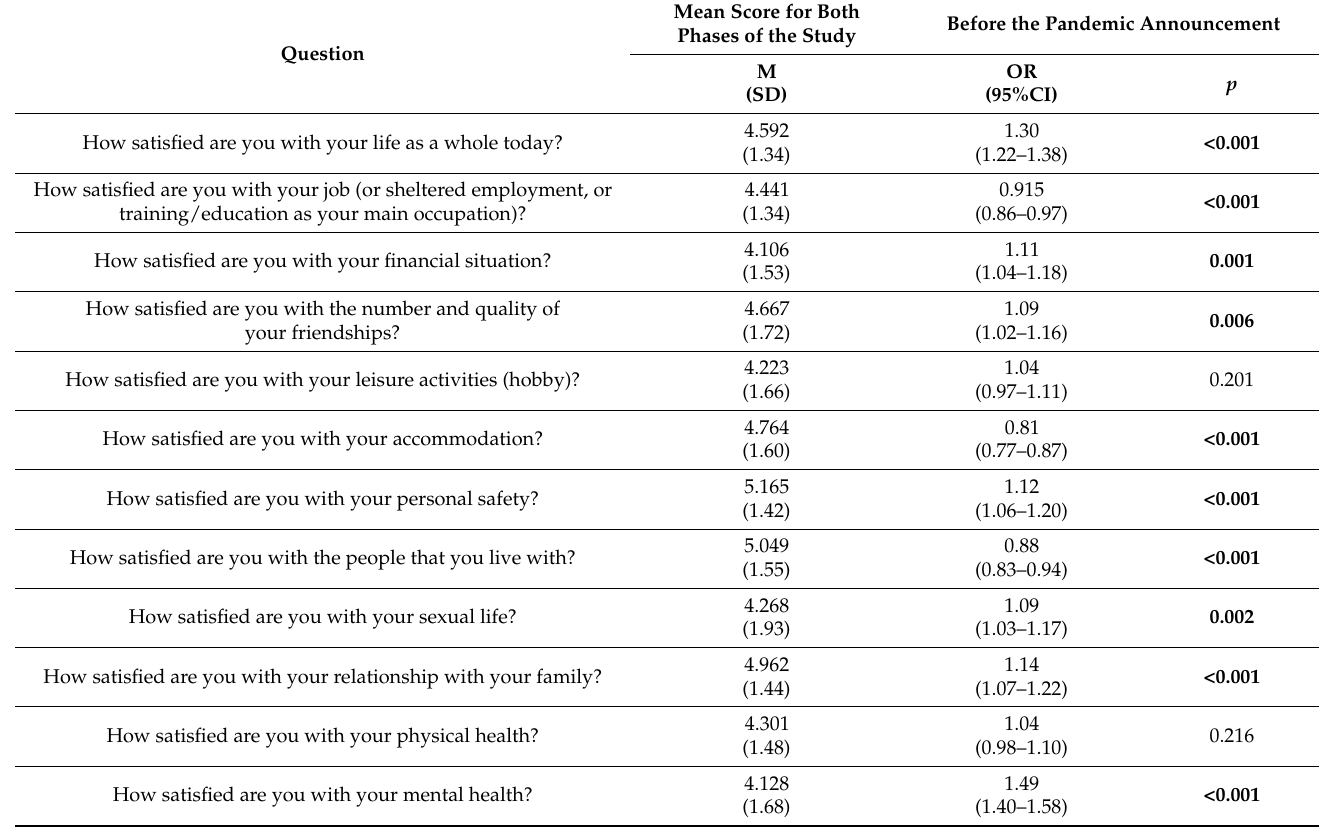
student population. There was a significant influence of gender on the type of stimulants. Women used sedatives/sleeping pills more often, whereas men consumed alcohol, and used cannabinoids and psychostimulants more often. With alcohol consumption, we ob- served a distinct pattern that a higher year of study was associated with increased alcohol use. It was also shown that after the COVID-19 pandemic burst, the frequency of using hyp- notics/sedatives by Polish students increased significantly (OR 0.76, p < 0.001). However, as the pandemic continued, alcohol consumption decreased (OR 1.35, p < 0.001). Table 4. Polynomial logistic regression analysis of the relationship between separate MANSA subscales and the COVID-19 pandemic in the ordinance. Mean Score for Both Phases of the Study